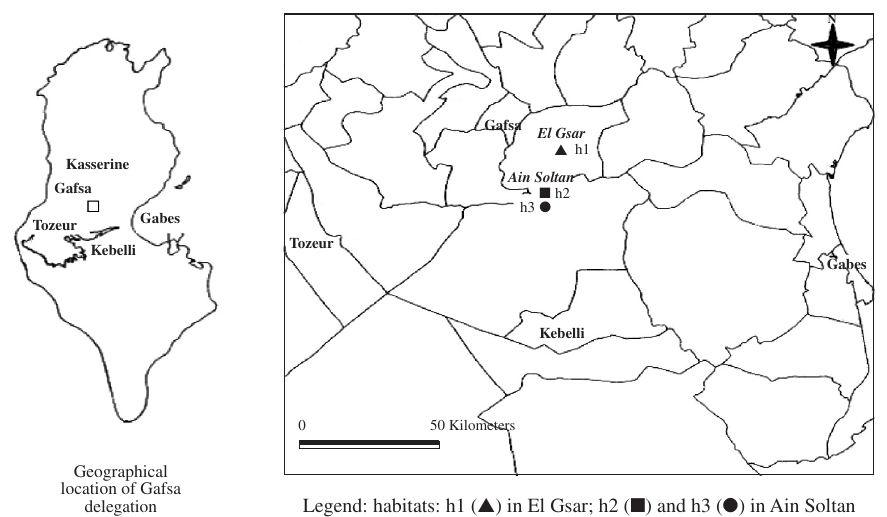
Fig 1. – Location of Galba truncatula habitats in Gafsa